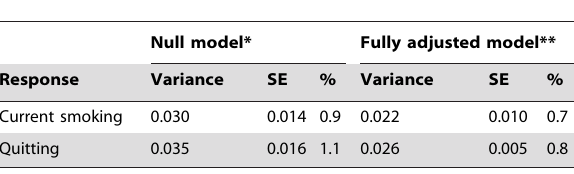
Table 3. Variance in current smoking and quitting between provinces in Canada; expressed as percentage of the contribution to the total variance.